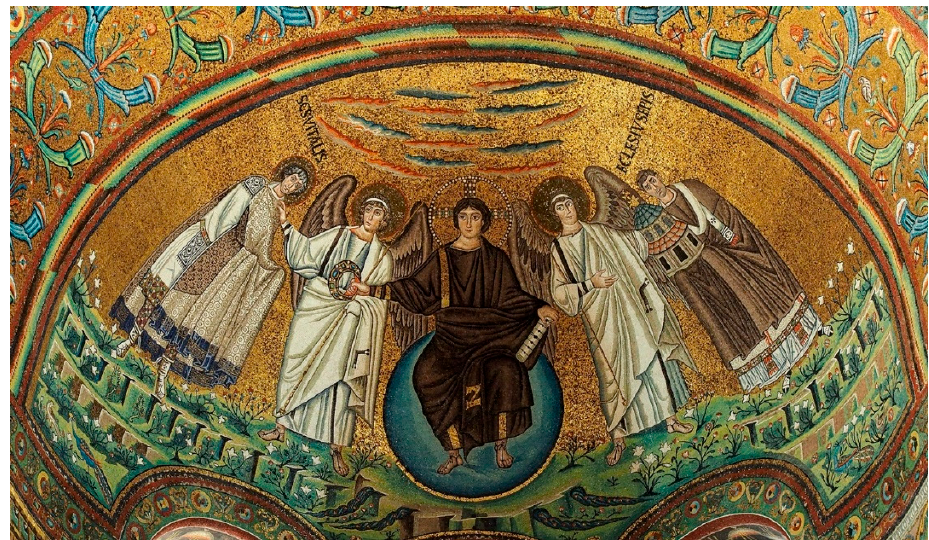
Figure 8. Apse mosaic, basilica of San Vitale, Ravenna (photo: Petar Miloševi ć , Wikimedia Commons, CC BY-SA 4.0).